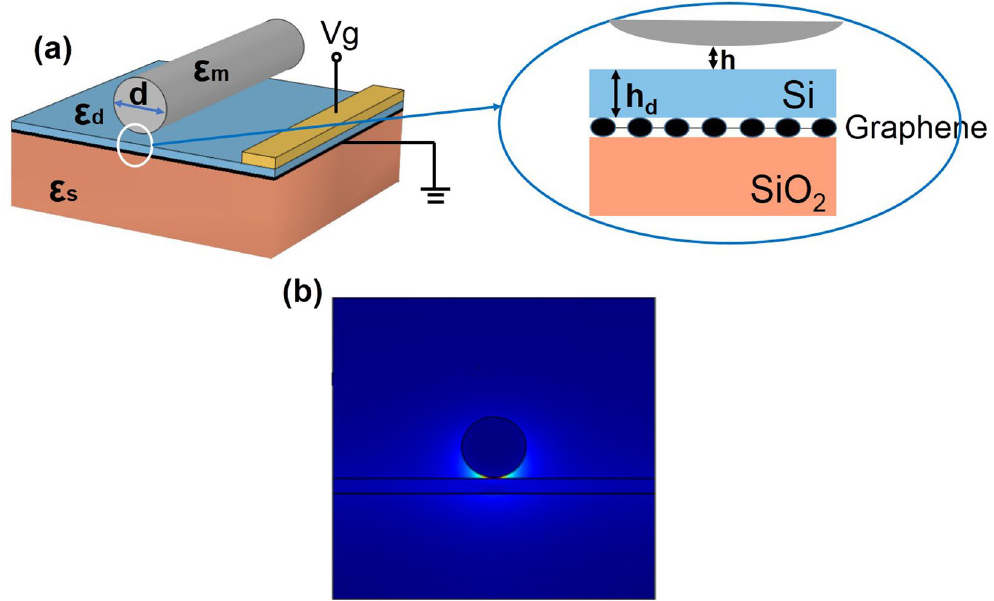
Figure 3. The structure and mode distributions of the designed GHPM. ( a ) Three dimensional structure and cross section of the proposed hybrid modulator. ( b ) The mode distributions of the designed modulator at a 1550 nm wavelength where d = 200 nm, h = 4 nm and h d = 50